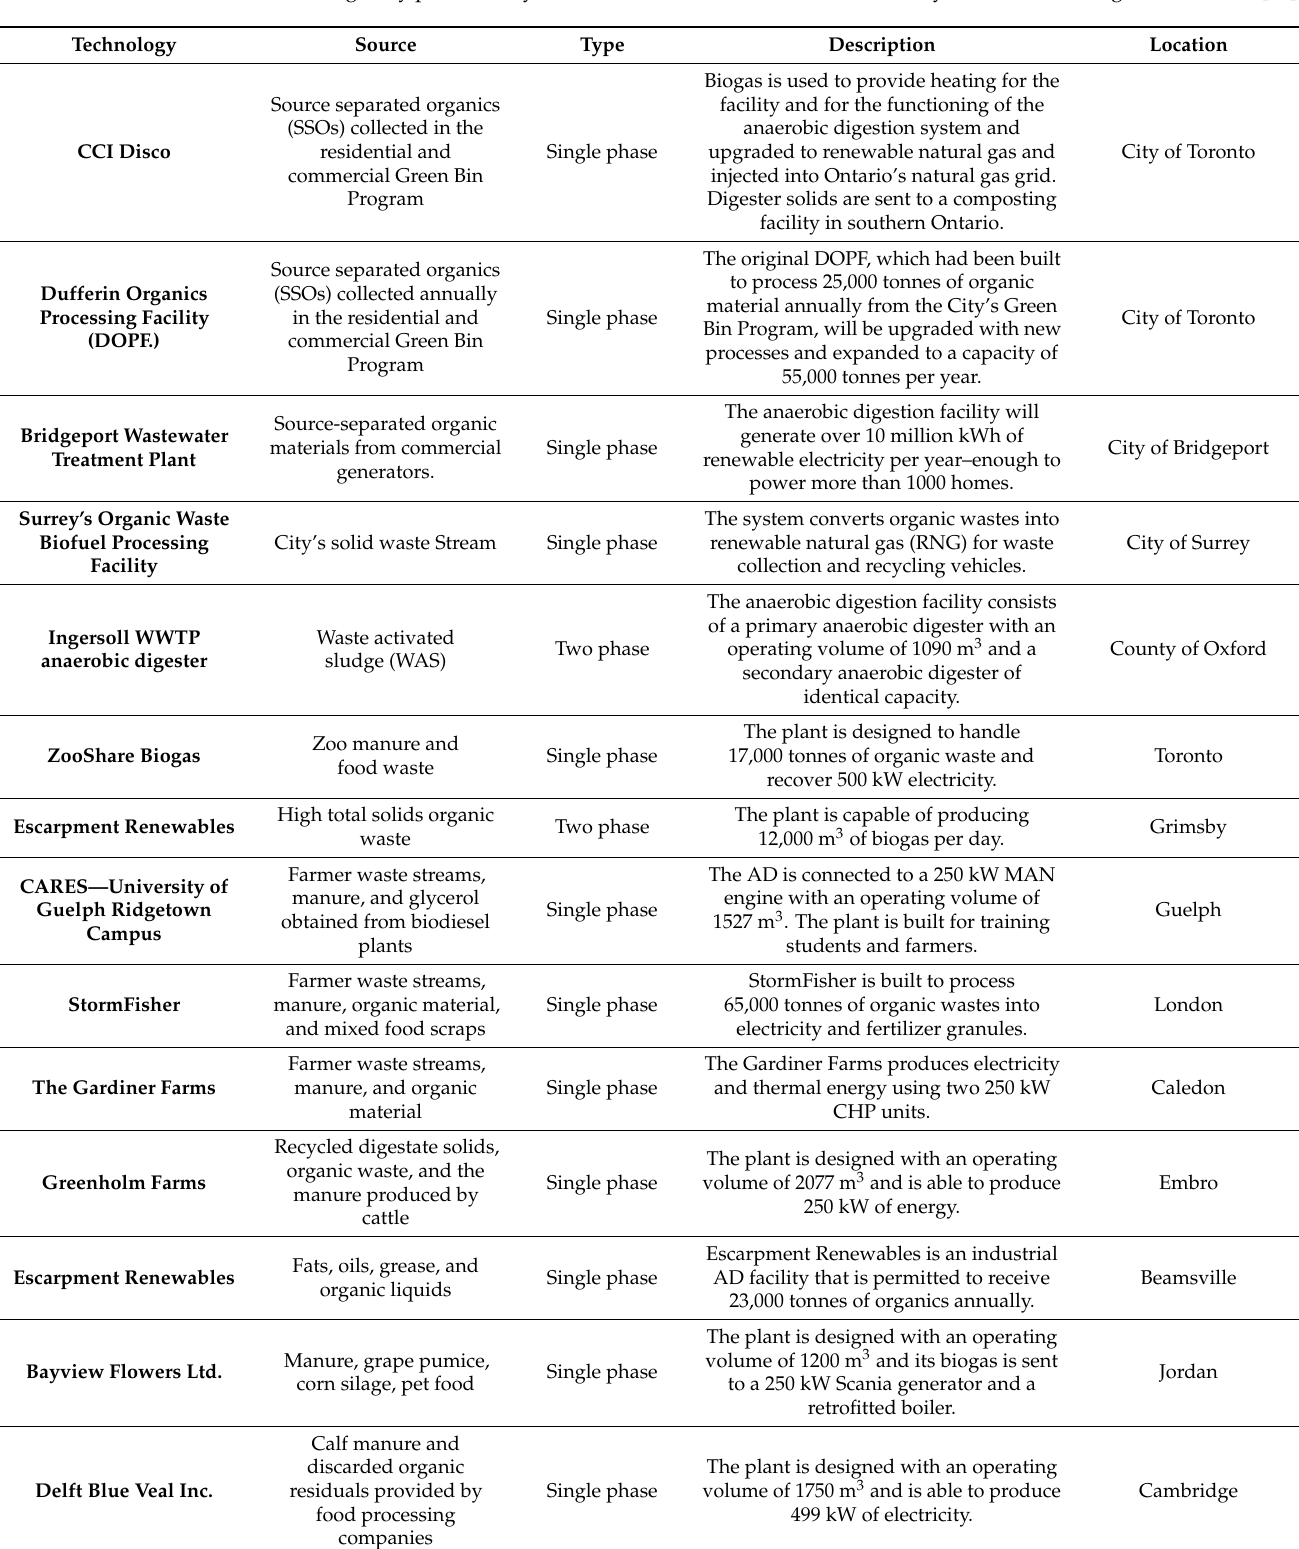
Table 3. Several biogas plants projects in Ontario for energy and resource recovery. The table was originally produced by the authors from the information shared by the Canadian Biogas Association